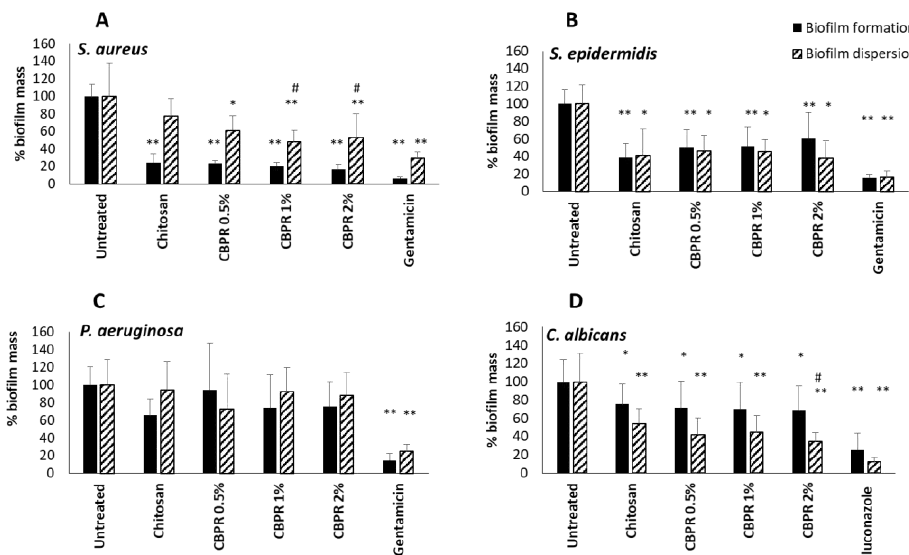
Figure 6. Effect of chitosan and CBPR films on the formation and dispersion of S. aureus ( A ), S. epidermidis ( B ), P. aeruginosa ( C ), and C. albicans biofilm ( D ). The data are expressed as a mean ± SD of the percentage of the biofilm mass (n = 12). The statistical analysis was performed with two-tailed Student’s t -test. * p ≤ 0.05, ** p ≤ 0.01 (chitosan- and CBPR-film-treated cells vs. untreated cells), # p ≤ 0.05 (CBPR-film-treated cells vs. chitosan-treated